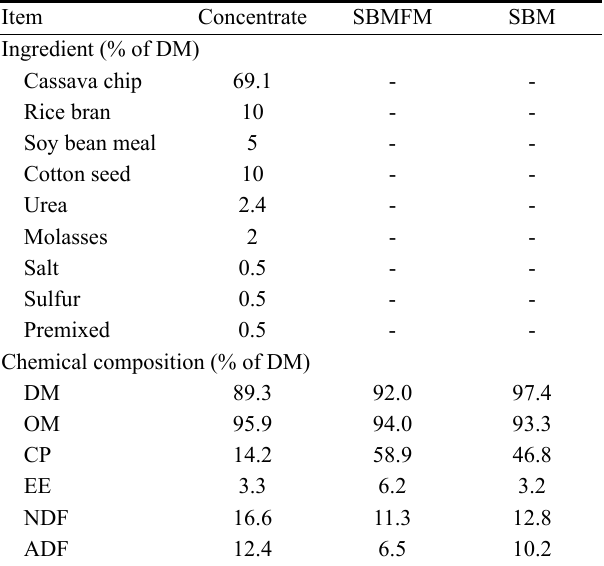
Table 2. Ingredients and chemical composition of concentrate used in this experiment